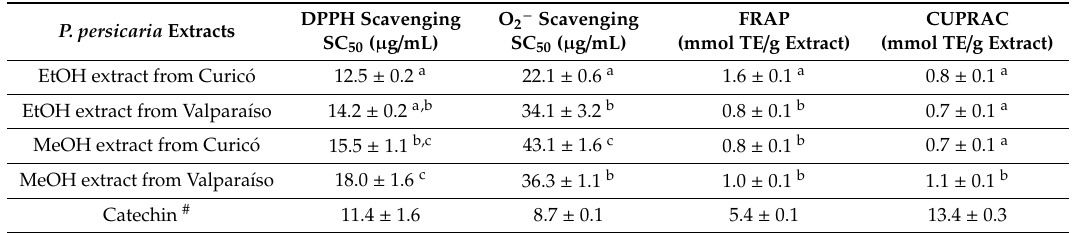
Table 2. Antioxidant activity of Persicaria maculosa extracts ( N = 3 / extract) * . P. persicaria